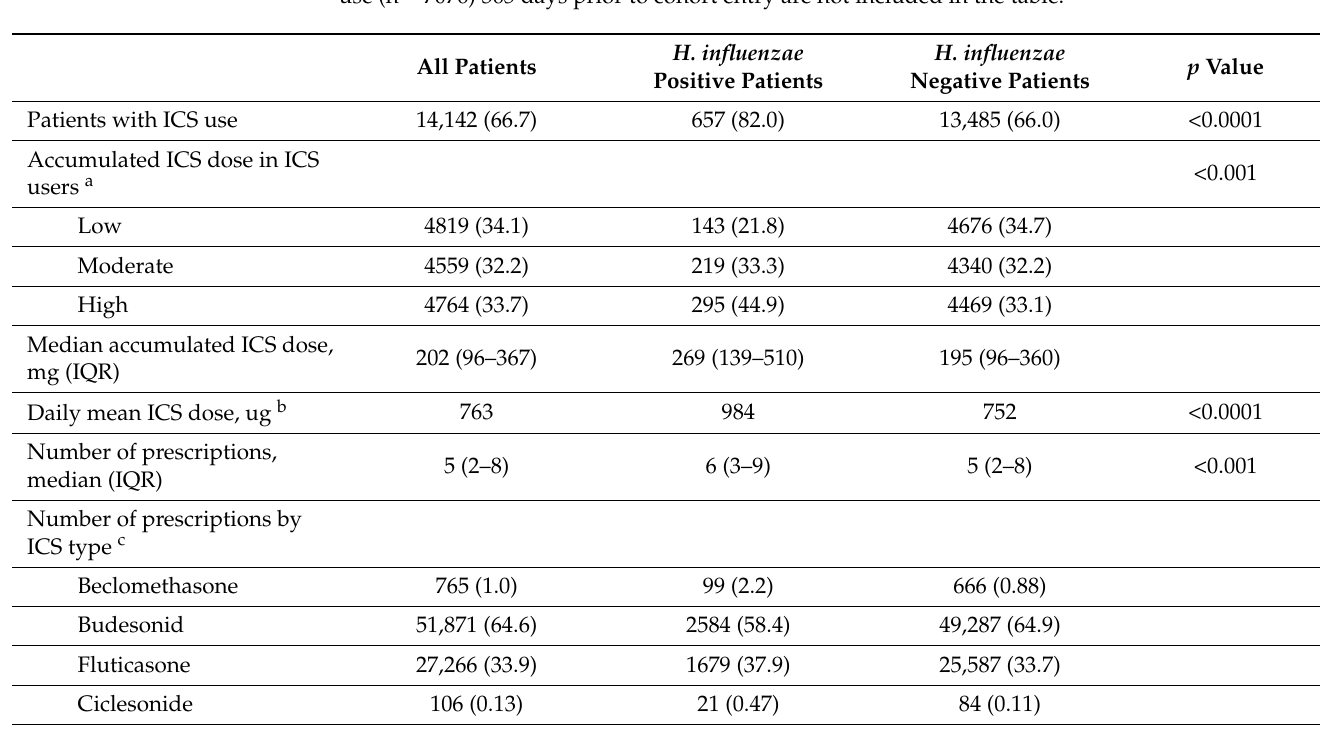
Table 2. Use of ICS 365 days prior to cohort entry in 21,218 patients with COPD. Patients with no ICS use (n = 7076) 365 days prior to cohort entry are not included in the